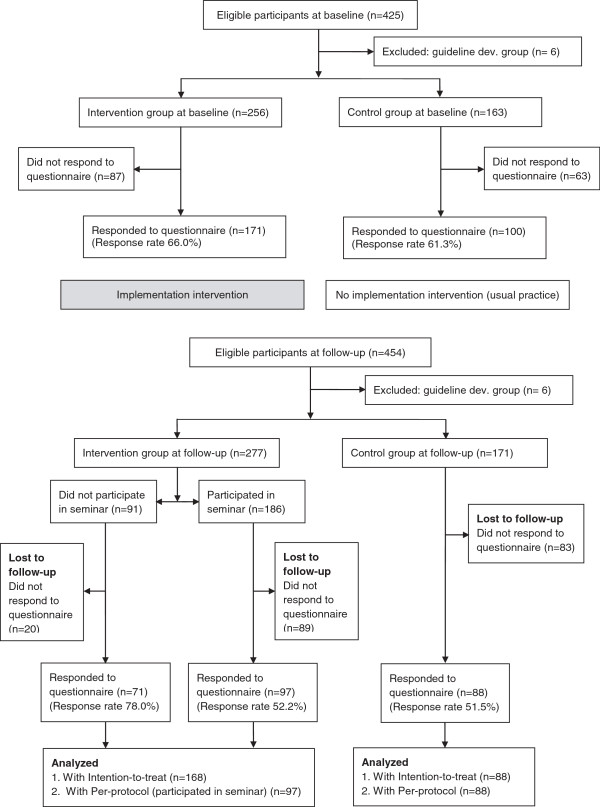
Flow chart of participants through the study.